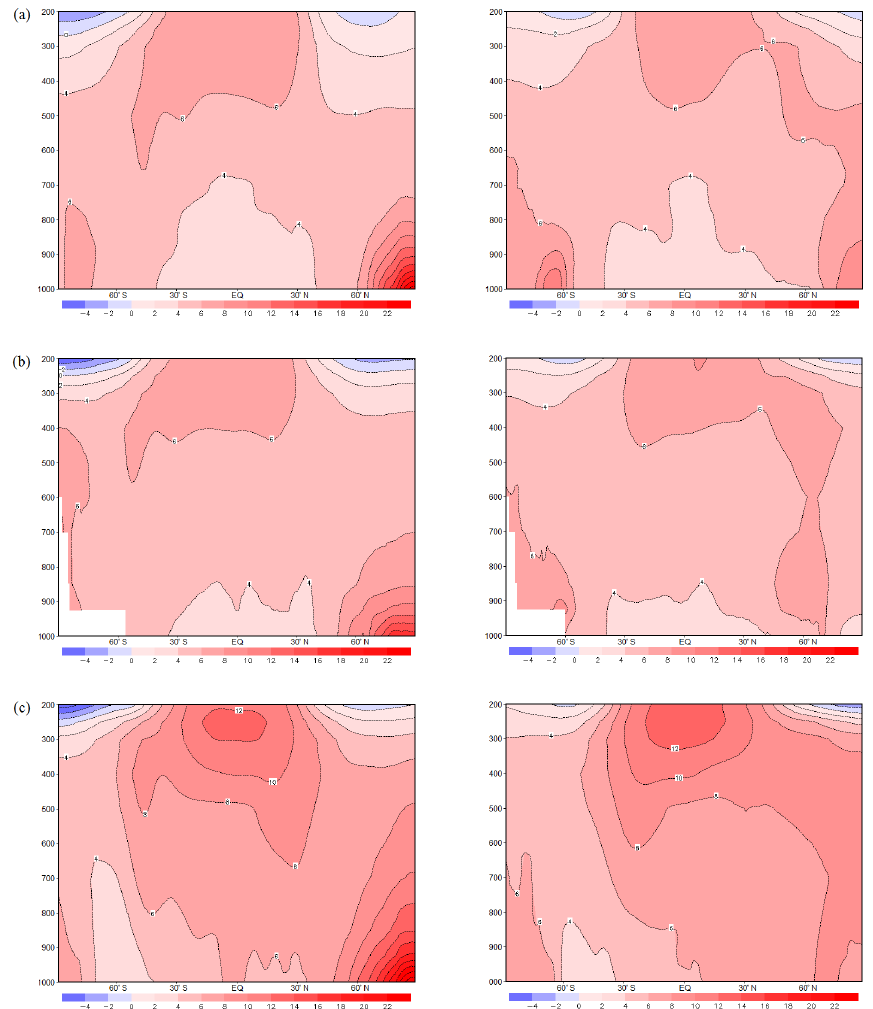
Figure 4. Zonal-average atmosphere temperature changes, in ◦ C (Abrupt-4 × CO 2 minus piControl) at each pressure level and in mb (solid line) for the last 30-year run for (a) BESM OA V2.5, (b) NCAR-CCSM4 and (c) the MPI-ESM-LR model, in DJF (left column) and JJA (right